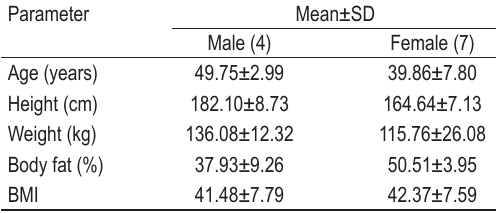
TABLE 3. Basic anthropometric characteristics of male and female participants upon enrollment into the